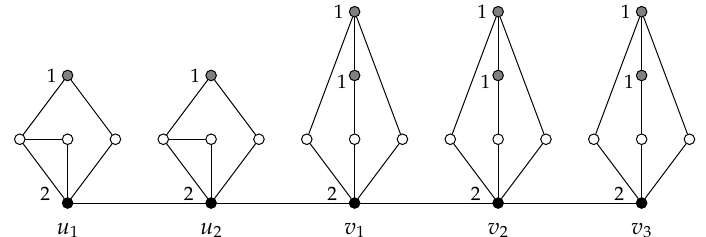
Figure 4. The graph G 2,3 by taking G as the path graph P 5 . The labels of (gray and black) coloured vertices describe the positive weights of a γ qtR ( G 2,3 )